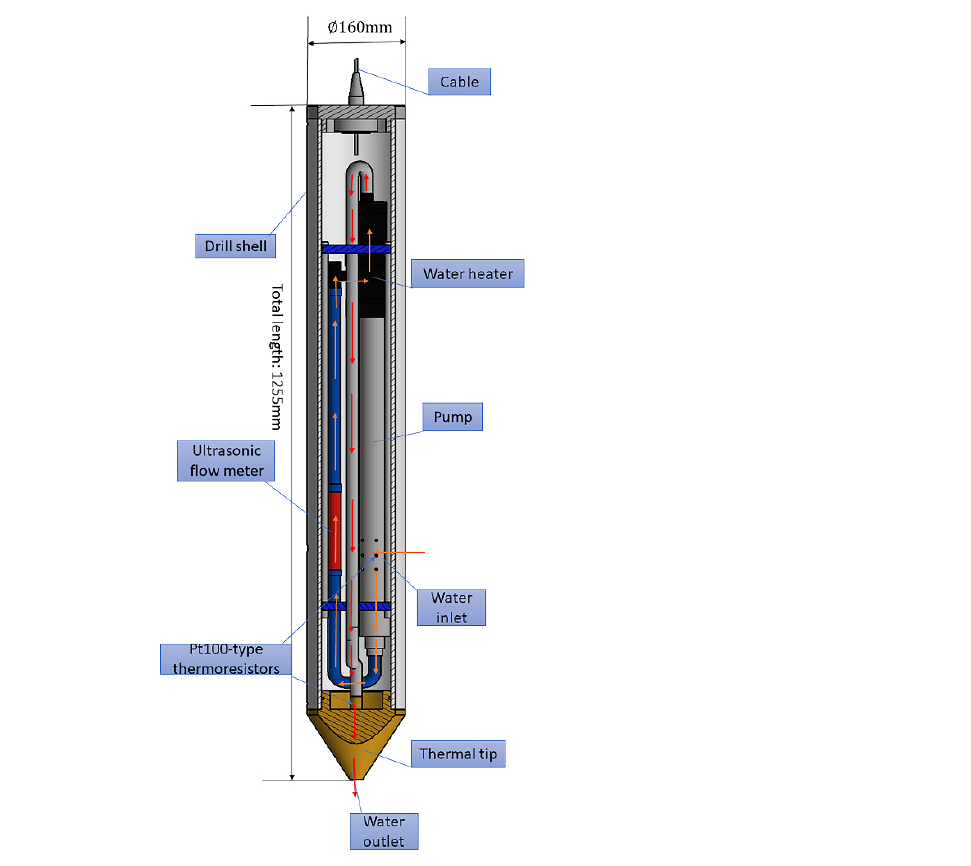
Figure 1. A 3D model of the hot-water drill prototype with near-bottom circulation.